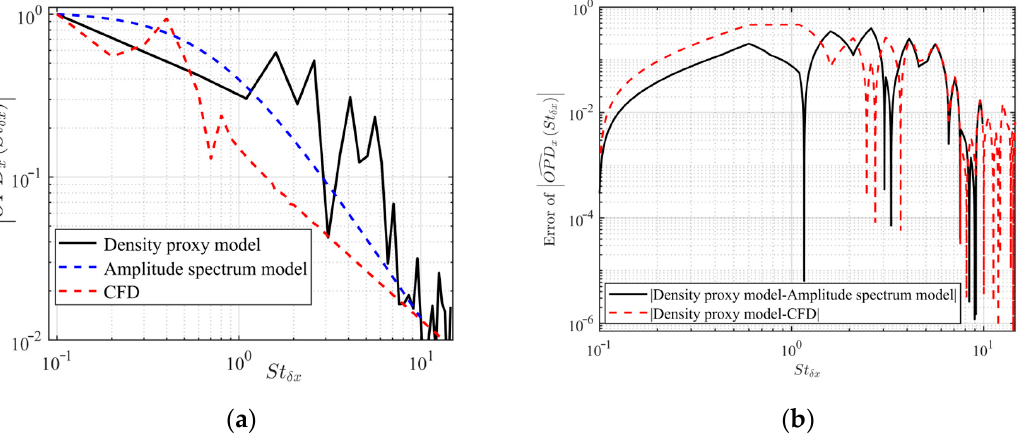
Figure 9. ( a ) OPD spectrum distribution of flow direction; ( b ) OPD spectrum distribution error of flow direction.